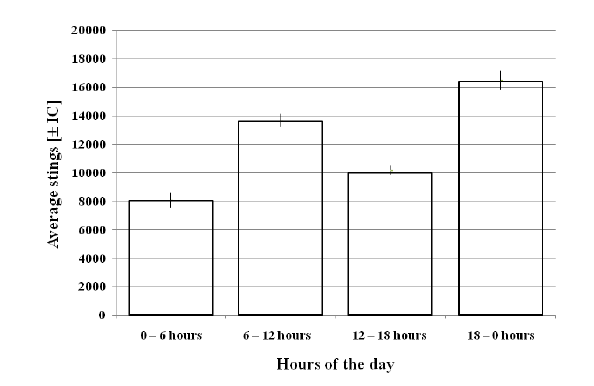
Figure 7. Daily distribution of scorpion sting incidence.